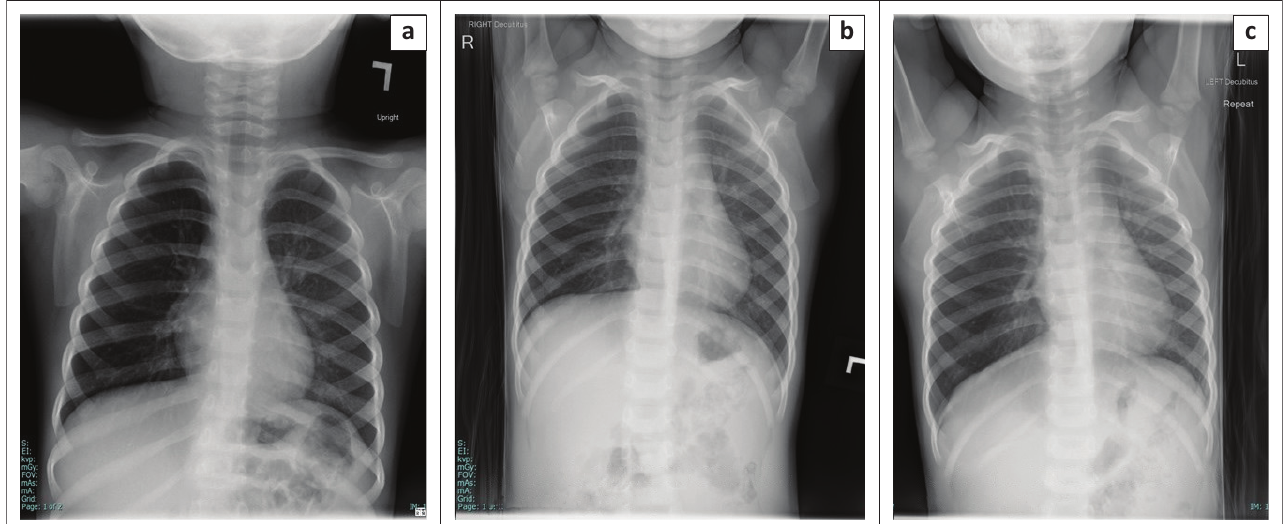
FIGURE 15: Images of a 30-month-old child with a history of almond aspiration. Although the foreign body was not radiographically visible, the chest radiograph (a) showed a hyperinflated right lung, and right lateral decubitus inspiratory (b) and expiratory films (c) demonstrated air trapping, suggesting foreign body aspiration into the right main bronchus.